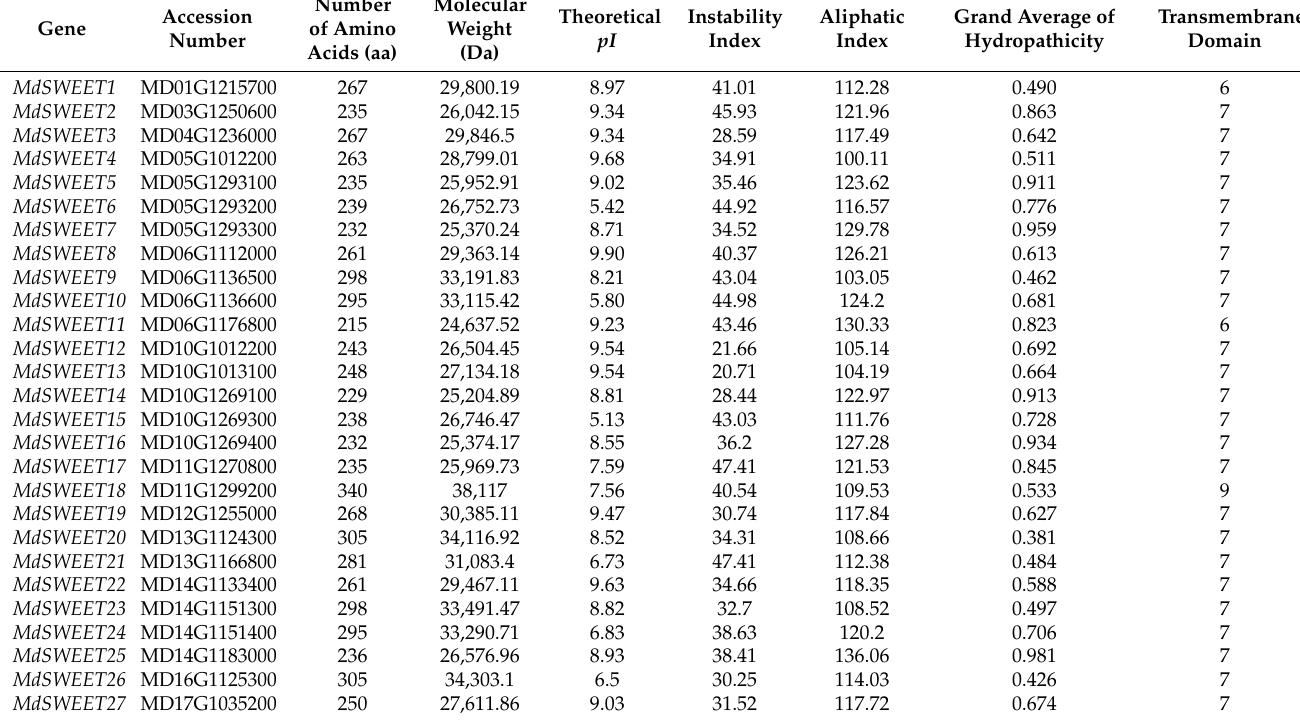
Table 1. Characterization of MdSWEET proteins in apple. The molecular weight, theoretical pI, instability index, aliphatic index, and grand average of hydropathicity were determined by the online ProtParam tool (http://web.expasy.org/protaram/ (accessed on 9 December 2020)). The number of transmembrane domains was predicted by PFAM (http://pfam.xfam.org/ (accessed